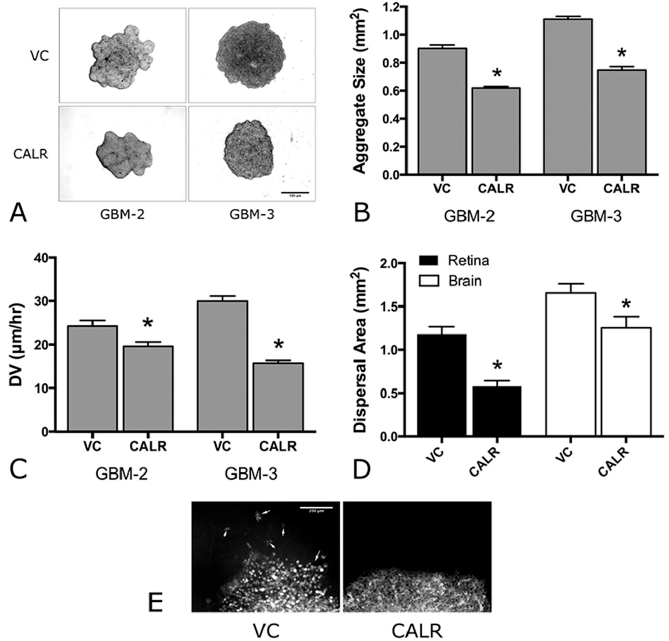
Figure 6. Effects of CALR expression on GBM dispersal. Compaction assay of GBM-2 and GBM-3 cells transfected with CALR plasmid (CALR) or empty vector control (VC). CALR appears to result in smaller aggregates ( A ). Quantification of CALR mediated compaction ( B ). Mean size and standard error for n = 10 aggregates of GBM-2 and GBM-3 after 48 h in culture. Asterisks represent statistical difference by pair-wise comparison and Student’s t -test, p < 0.0001). Measurement of dispersal velocity ( C ). The dispersal velocities of CALR transfected aggregates of GBM-2 and GBM-3 ( n = 31 and n = 28, respectively) was significantly lower than that measured for control aggregates ( n = 28 and n = 31). Asterisks represent significant difference at p < 0.05 by pair-wise comparison using Student’s t -test. Ex vivo retina dispersal assay ( D ). Dispersal of GBM aggregates on extirpated mouse retinas and on mouse brain slices was quantified by placing aggregates of fluorescently labeled control ( n = 12) or CALR-transfected ( n = 12) GBM-2 cells on mouse retinas and brain slices and incubation under tissue culture conditions for 24 h. Asterisk represents significant difference by Student’s t -test, p < 0.0001. Representative image of aggregate spreading by control and CALR aggregates of GBM-2 on mouse retina. Note single cell dispersal from control aggregates (white arrows, VC), in contrast to the higher level of cell-cell contact at the advancing cell front observed for CALR aggregates ( E ). Signal in panel E (fluorescent, membrane intercalating dye,